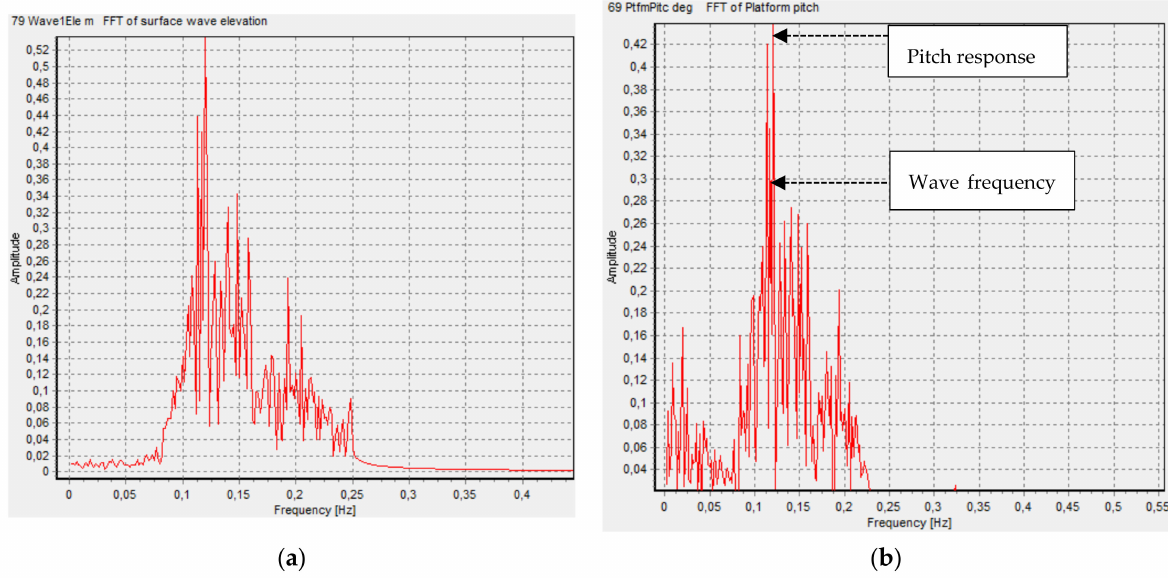
Figure 11. FFT of wave surface elevation ( a ) and pitch motion ( b